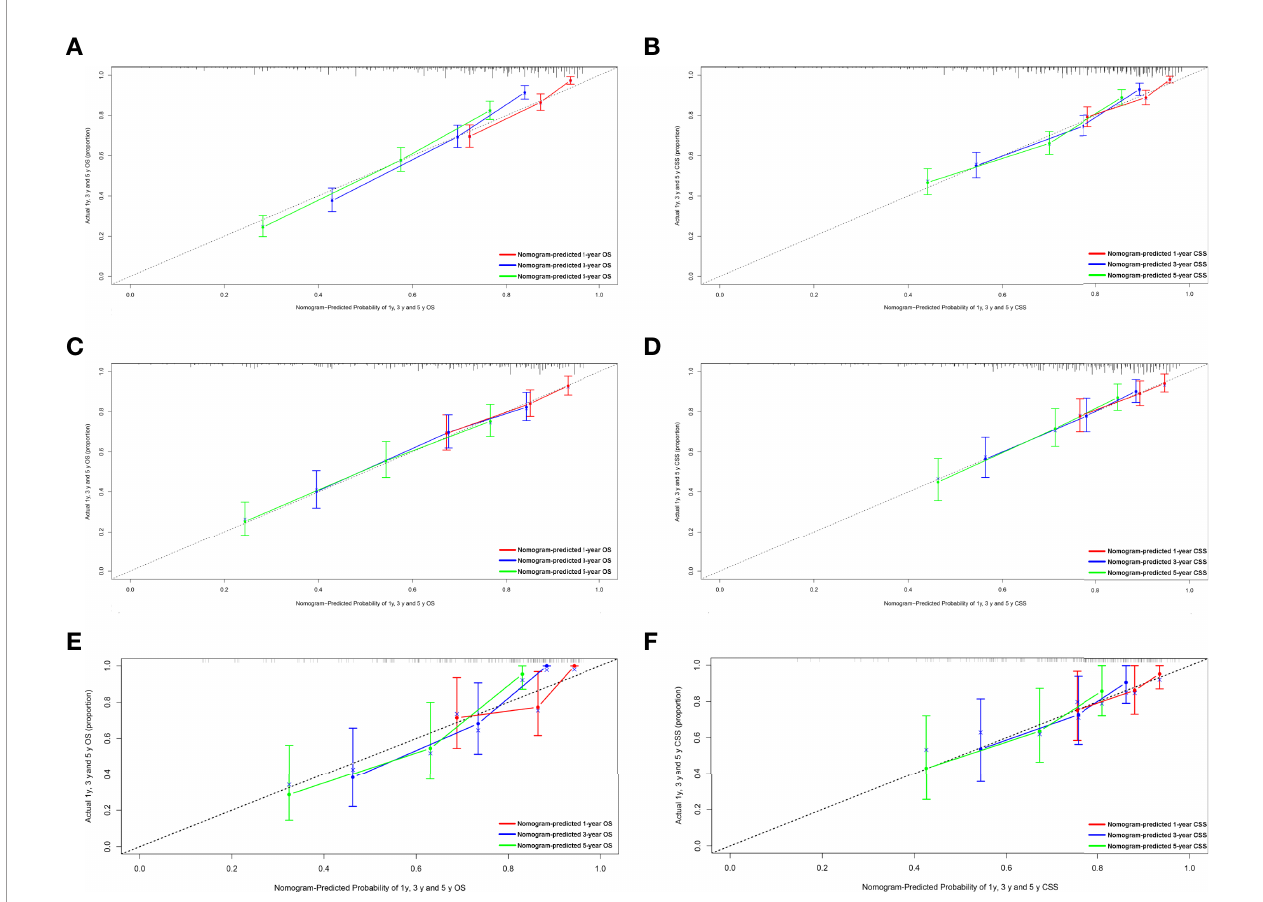
FIGURE 4 | Calibration plots of the nomogram for 1-, 3-, and 5-year OS and CSS prediction. (A) Calibration curves of 1-, 3-, and 5-year OS in the training cohort. (B) Calibration curves of 1-, 3-, and 5-year CSS in the training cohort. (C) Calibration curves of 1-, 3-, and 5-year OS in the internal validation cohort. (D) Calibration curves of 1-, 3-, and 5-year CSS in the internal validation cohort. (E) Calibration curves of 1-, 3-, and 5-year OS in the external validation cohort. (F) Calibration curves of 1-, 3-, and 5-year CSS in the external validation cohort. OS, overall survival; CSS, cancer-speci fi c